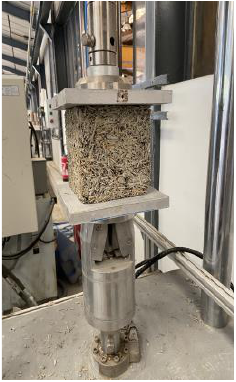
Figure 6. Compression strength test on rapeseed concrete.